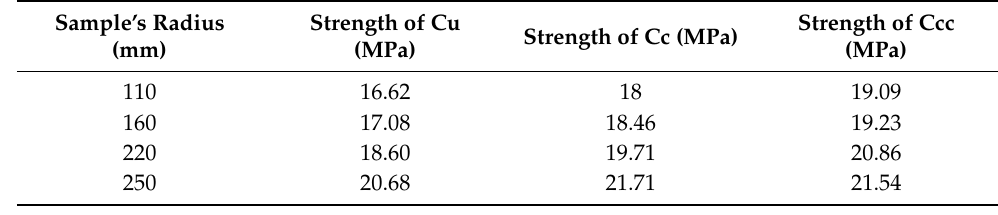
Table 8. The improvement of compressive strength using PVC tubes at 7 days.